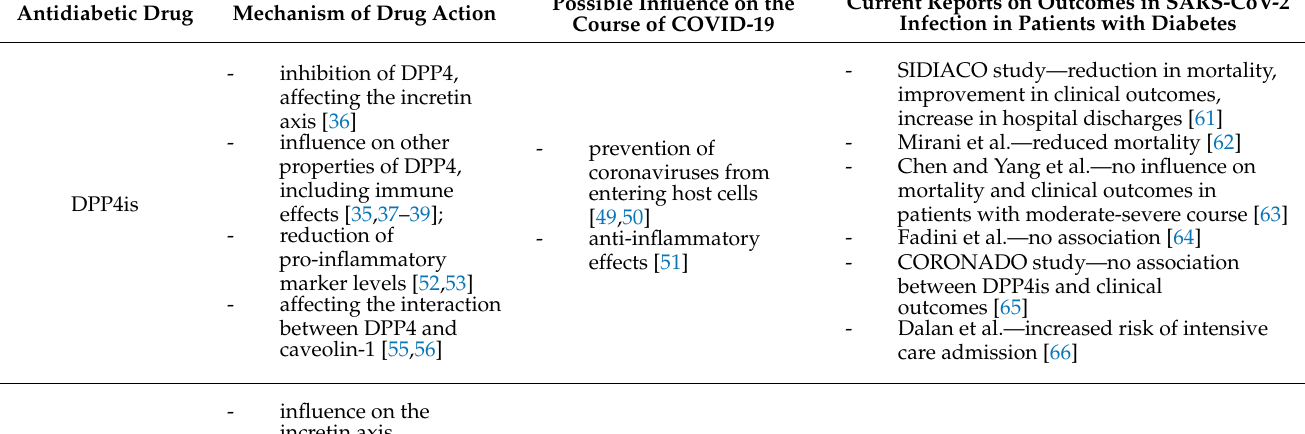
Table 1. A summary of antidiabetic drugs, their mechanisms of action, their possible influence on the course of COVID-19 and current reports regarding impact of these drugs on the course of SARS-CoV-2 infection in patients with diabetes. Antidiabetic